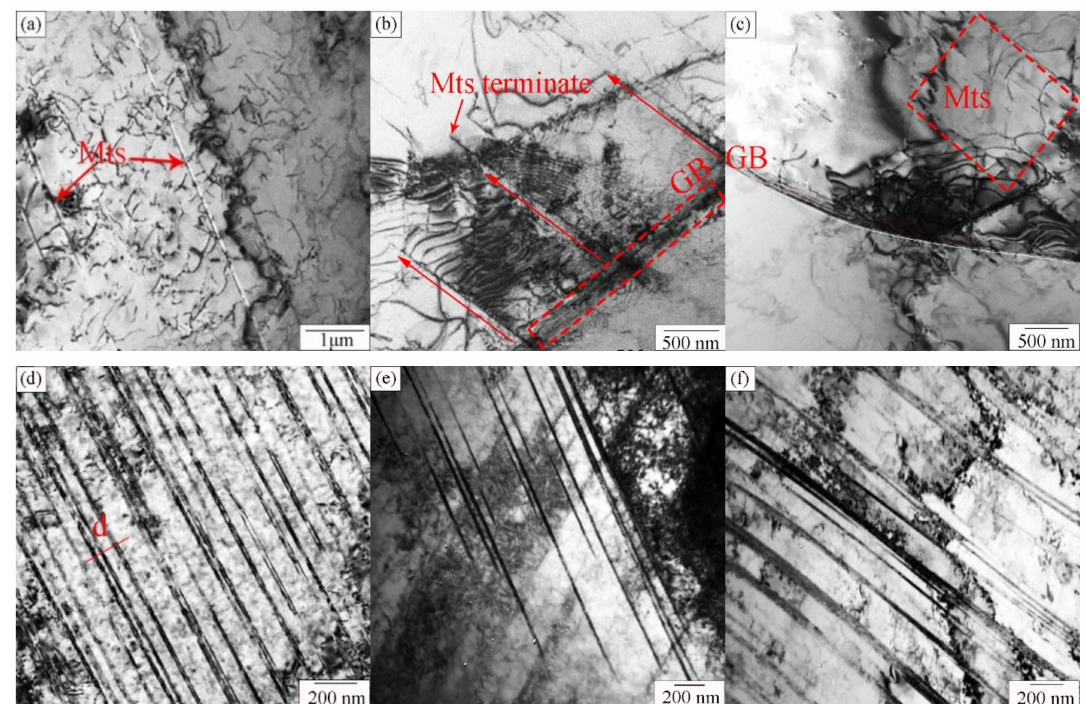
Figure 5. TEM photos under yield strain at room temperature: ( a ) 12Cr–CN, ( b ) 19Cr–0.7N, ( c ) 19CrSi– 0.7N at yield strain; ( d ) 12Cr–CN, ( e ) 19Cr–0.7N, ( f ) 19CrSi–0.7N at 10%